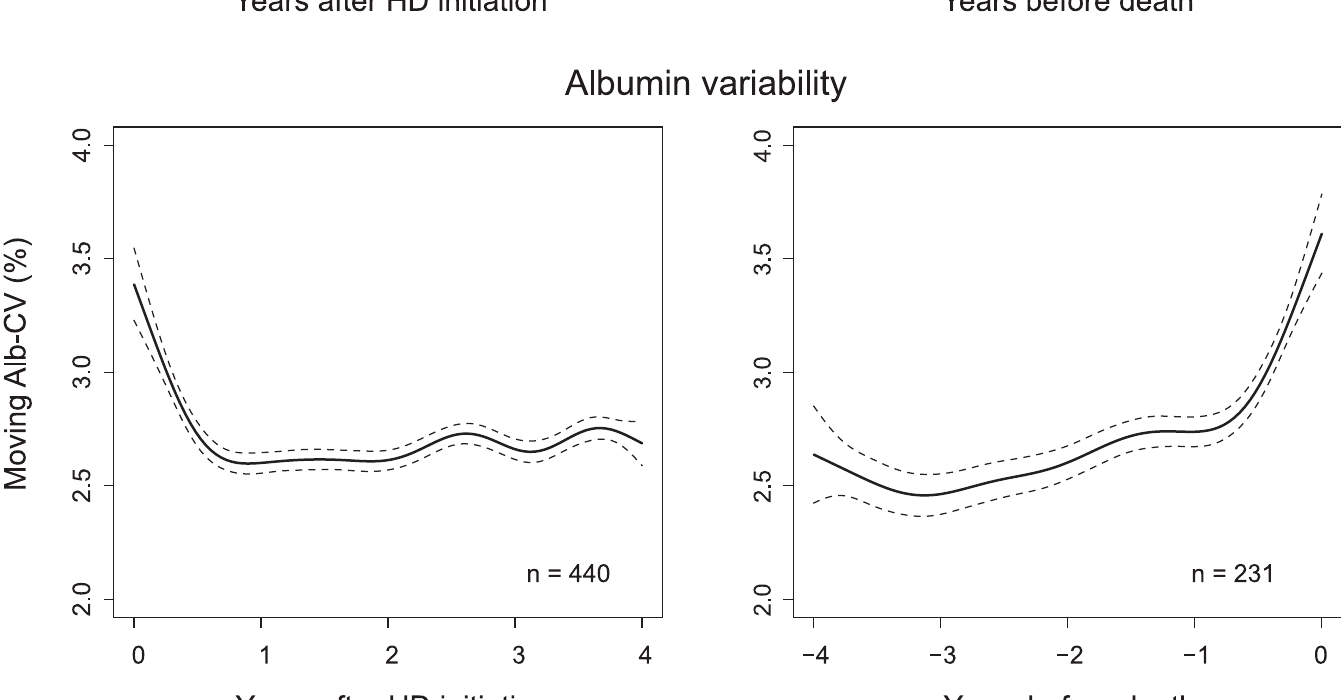
PLOS ONE | https://doi.org/10.1371/journal.pone.0185216 September 27,